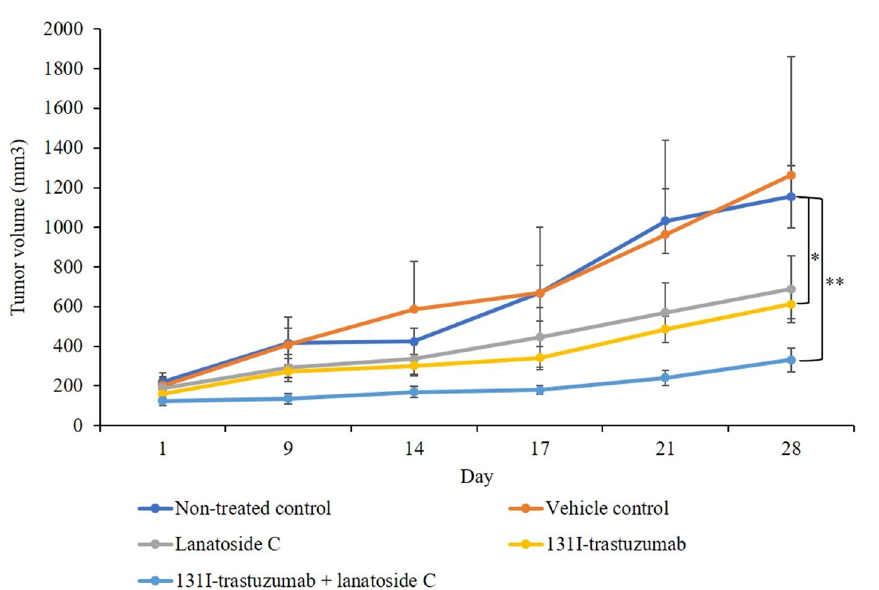
Figure 3. Lanatoside C enhanced 131 I-trastuzumab RIT in xenograft model. When the NCI-N87 tumor volume reached approximately 150 mm 3 , the BALB/c nude mice were treated with non-treated control group (untreated control), vehicle control group (0.01% DMSO in saline, 100 μl, the first 3 days), lanatoside C (6 mg/kg body weight, the first 3 days intraperitoneal injection), 131 I-trastuzumab group (400 μCi, once tail vein injection), and combination of 131 I-trastuzumab and lanatoside C (lanatoside C, 6 mg/kg body weight, the first 3 days intraperitoneal injection, and 131 I-trastuzumab, 400 μCi, once tail vein injection). ** p < 0.01, and * p <